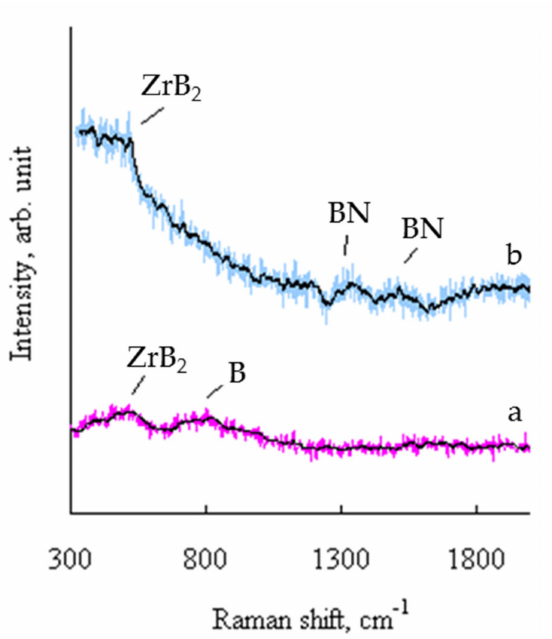
Figure 4. Raman spectra of the coatings 1 (100%Ar) ( a ) and 2 (85%Ar + 15%N 2 ) ( b ). TEM images of the microstructures and SAED patterns of the coatings 1 and 2 are presented in Figure